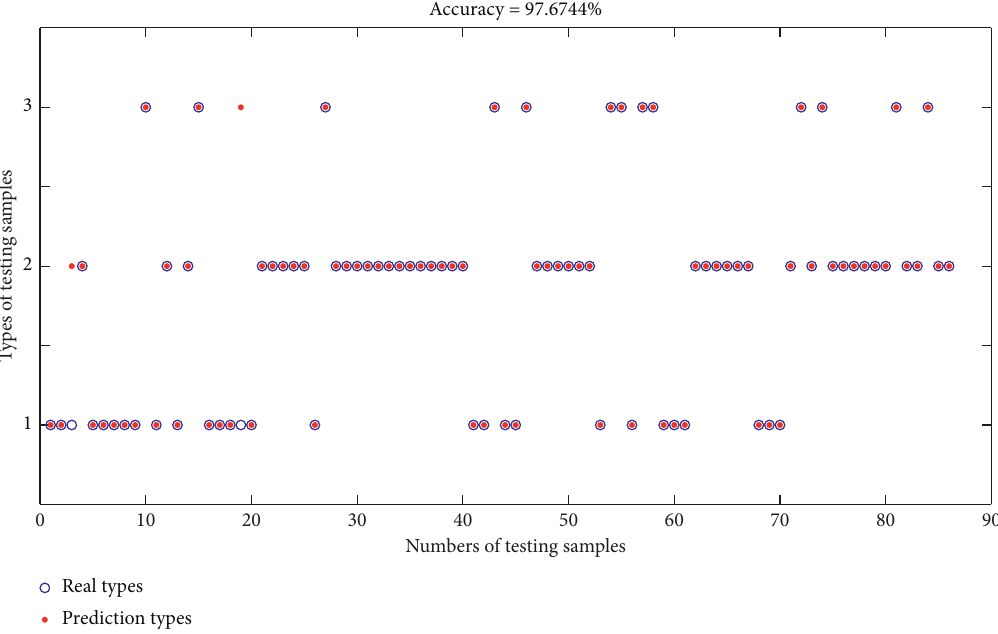
Figure 4: Prediction results of testing samples by SVM classification model of No.